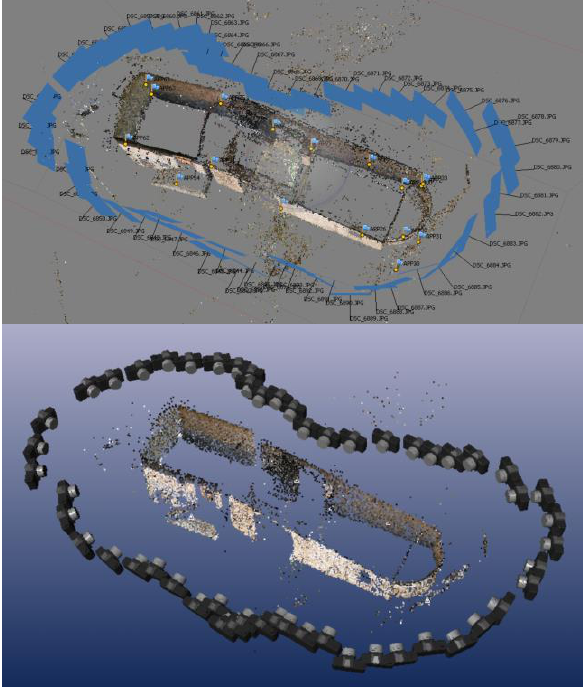
Figure 10. Image orientation results for PhotoScan (top) and PhotoModeler